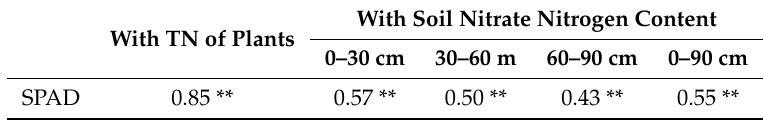
Table 6. SPAD and all winter wheat N status parameters were significantly correlated. The correlation coe ffi cients between the SPAD value and soil nitrate nitrogen content decreased gradually with the increase of soil depth. Table 6. Correlation coe ffi cients between SPAD value and N status of plant and soil. With Soil Nitrate Nitrogen With TN of Plants